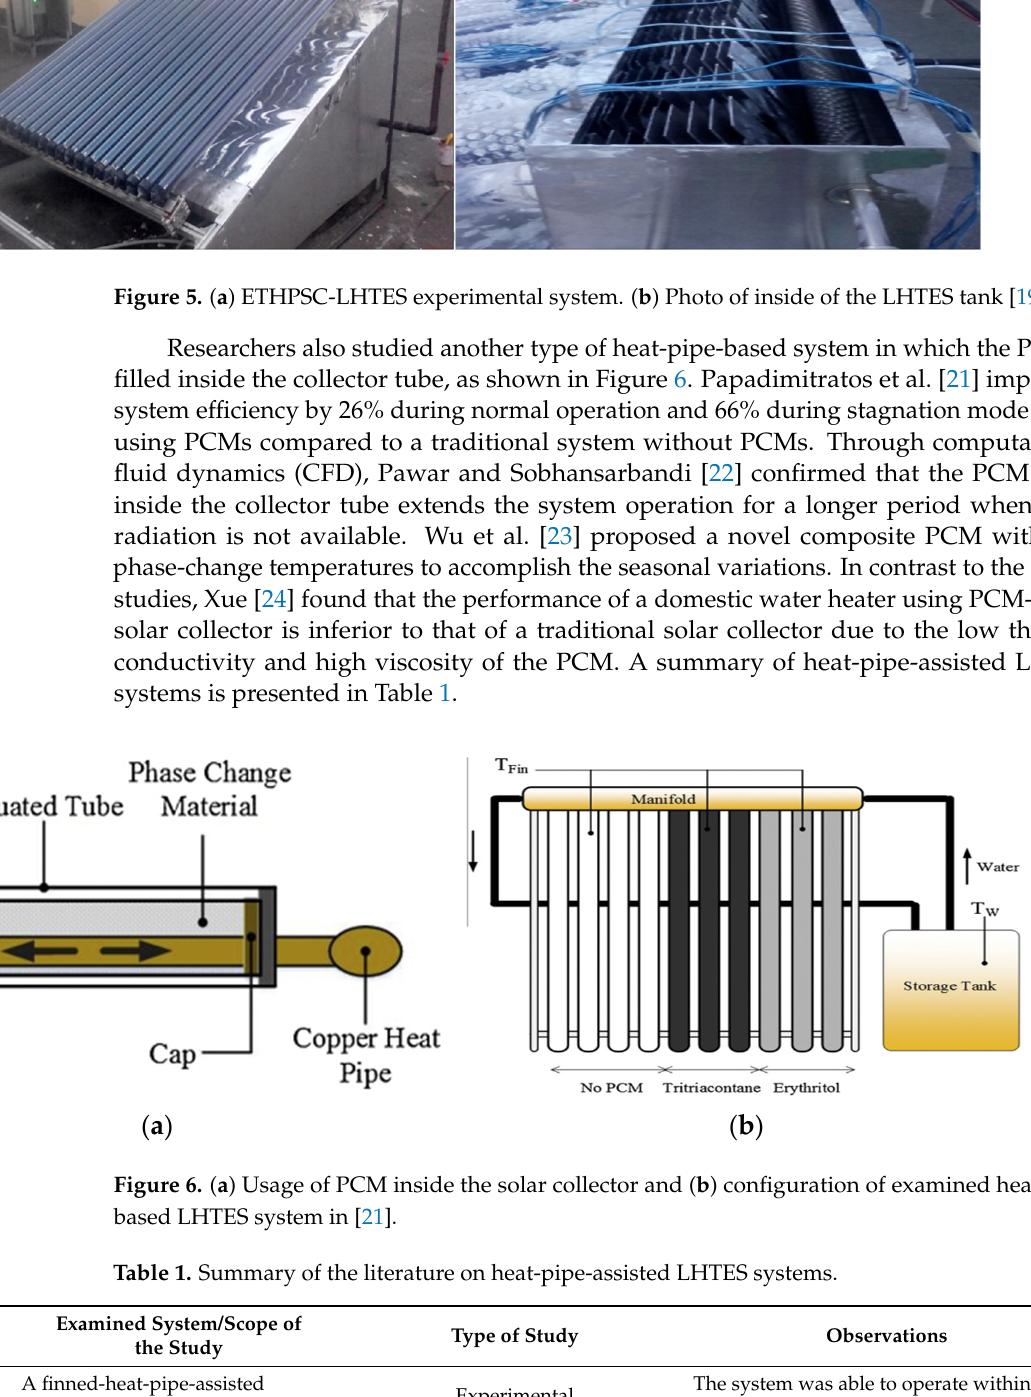
Figure 4. ( a ) ETHPSC-LHTES system studied in [14]; ( b ) fin design for condenser section ( top ) and water pipe ( bottom ).